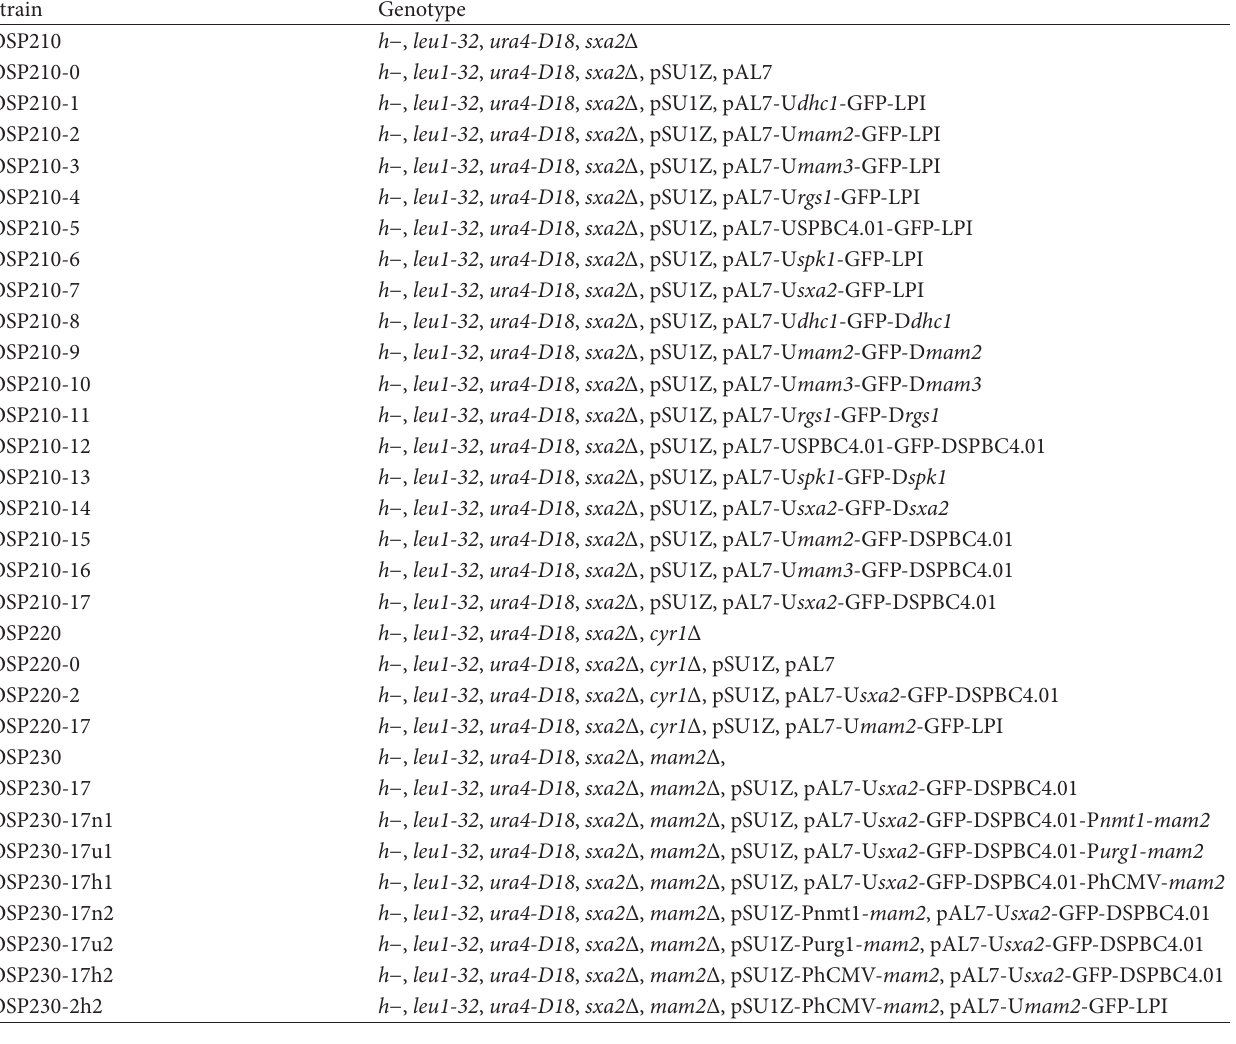
T 1: Fission yeast strains used in this